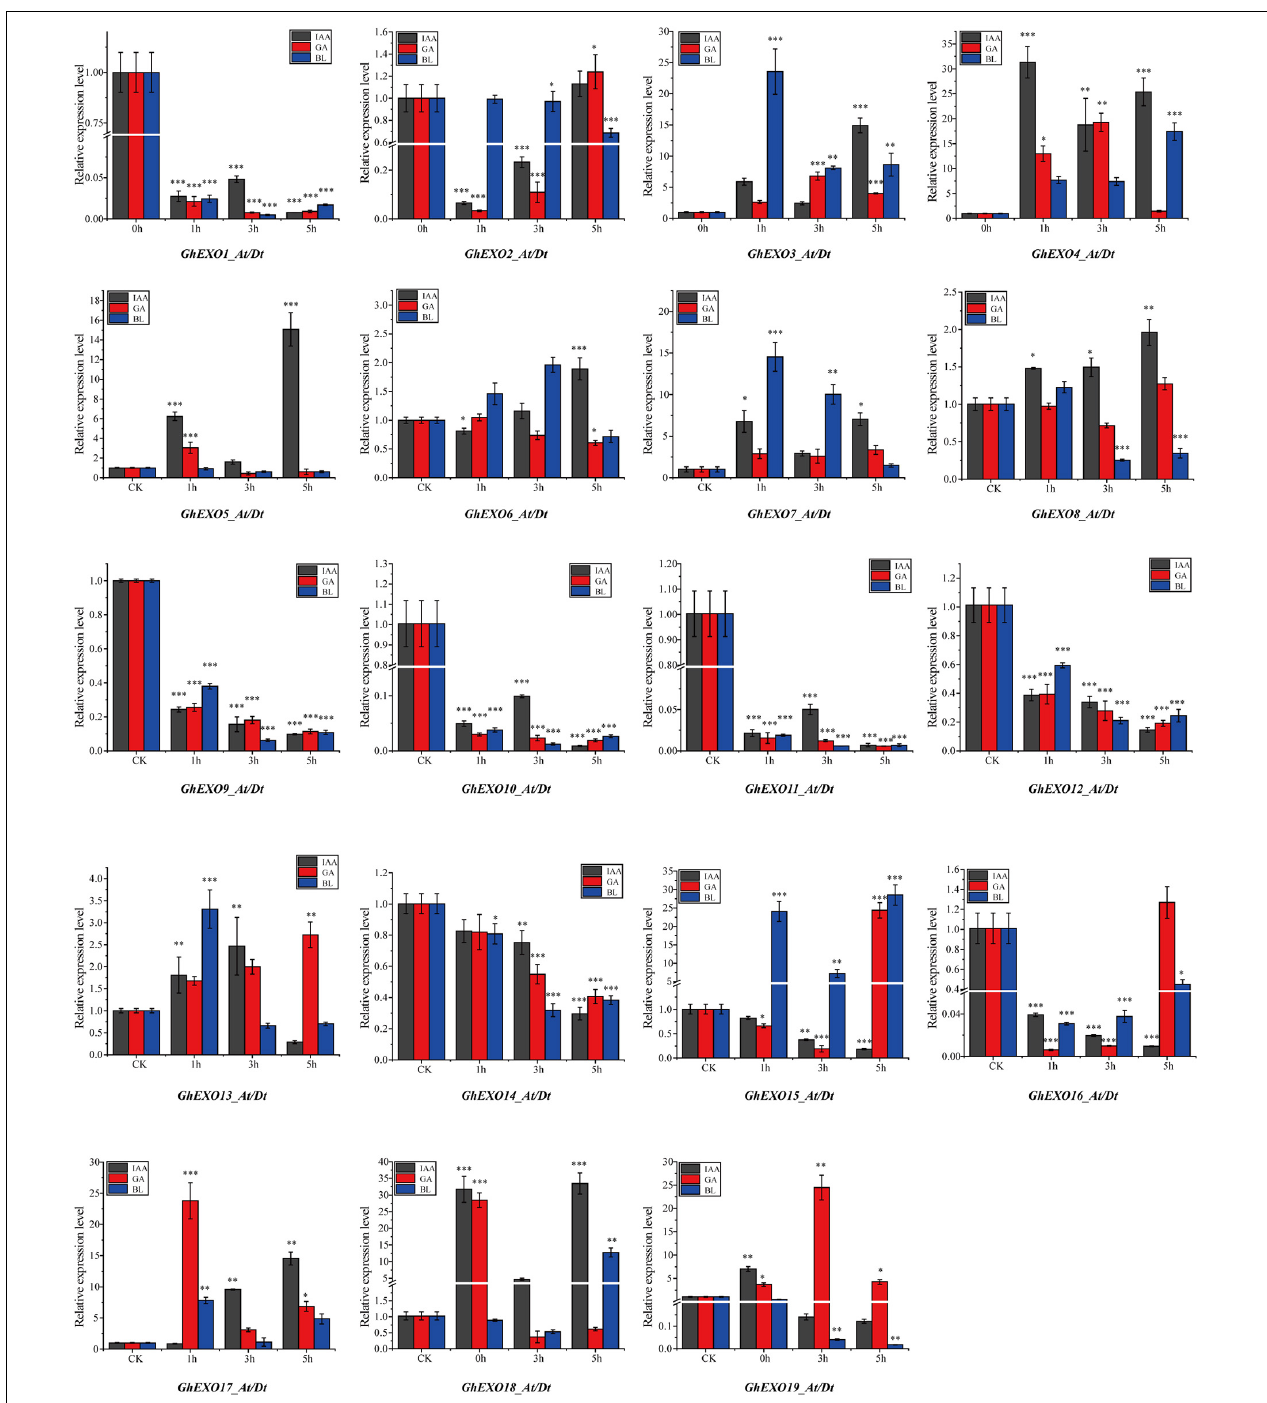
FIGURE 5 | Expression pattern analysis of GhEXO genes under hormone treatment. Expression patterns of 19 GhEXO genes in response to three hormone treatments (IAA, GA, and BL) as determined by qRT-PCR analysis. The error bars show the standard deviations of three independent repeats. Student’s t -test: ∗ p < 0.05, ∗∗ p < 0.01, ∗∗∗ p < 0.001.